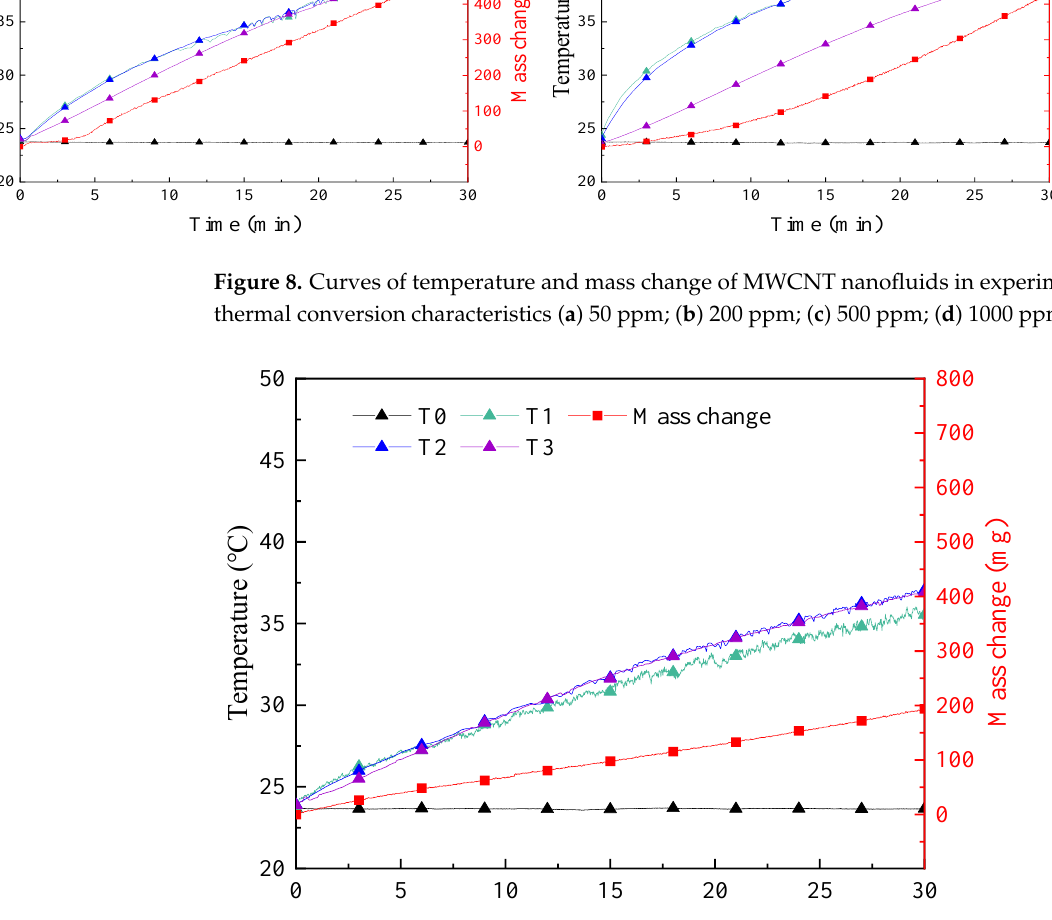
Figure 9. Curves of temperature and mass change of SiO 2 nanofluids of 1000 ppm in experiments on solar – thermal conversion characteristics.